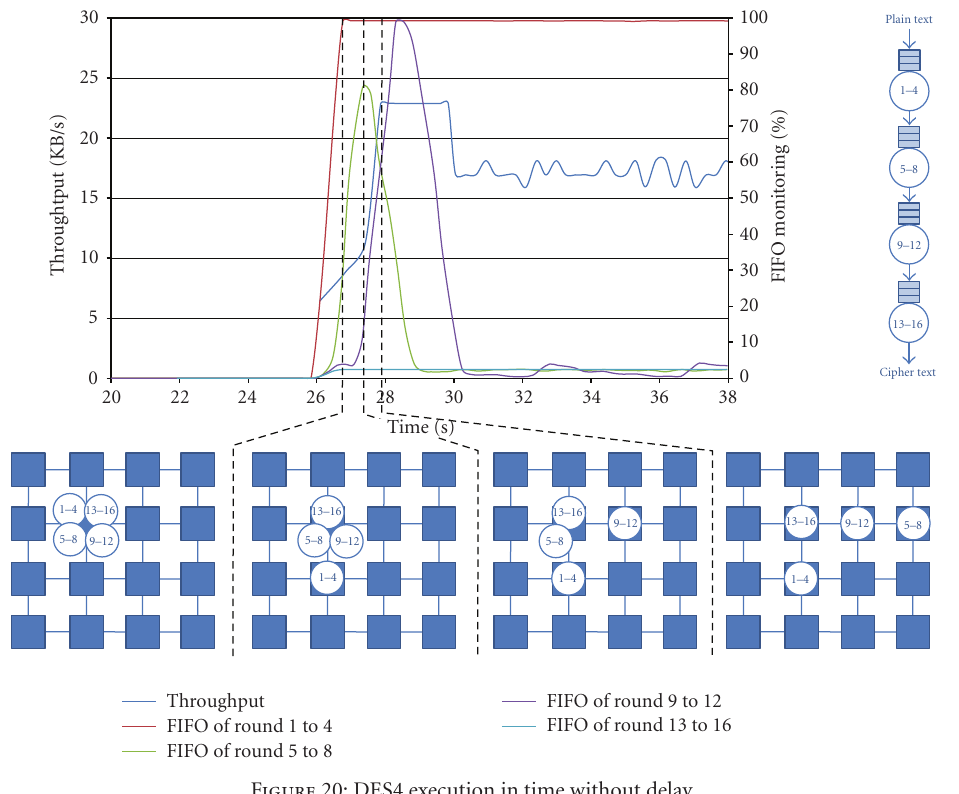
Figure 20: DES4 execution in time without delay.